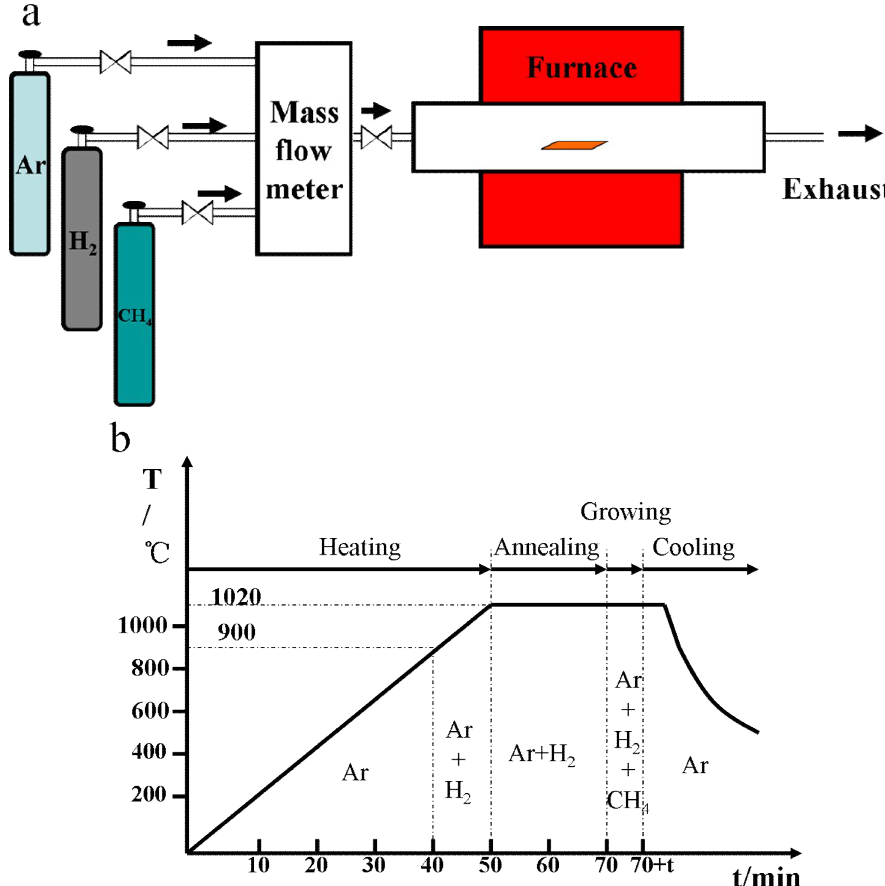
Figure 1. ( a ) Schematic illustration of the chemical vapor deposition (CVD) synthesis of graphene. ( b ) The process of graphene growth by CVD (t = 90 s).